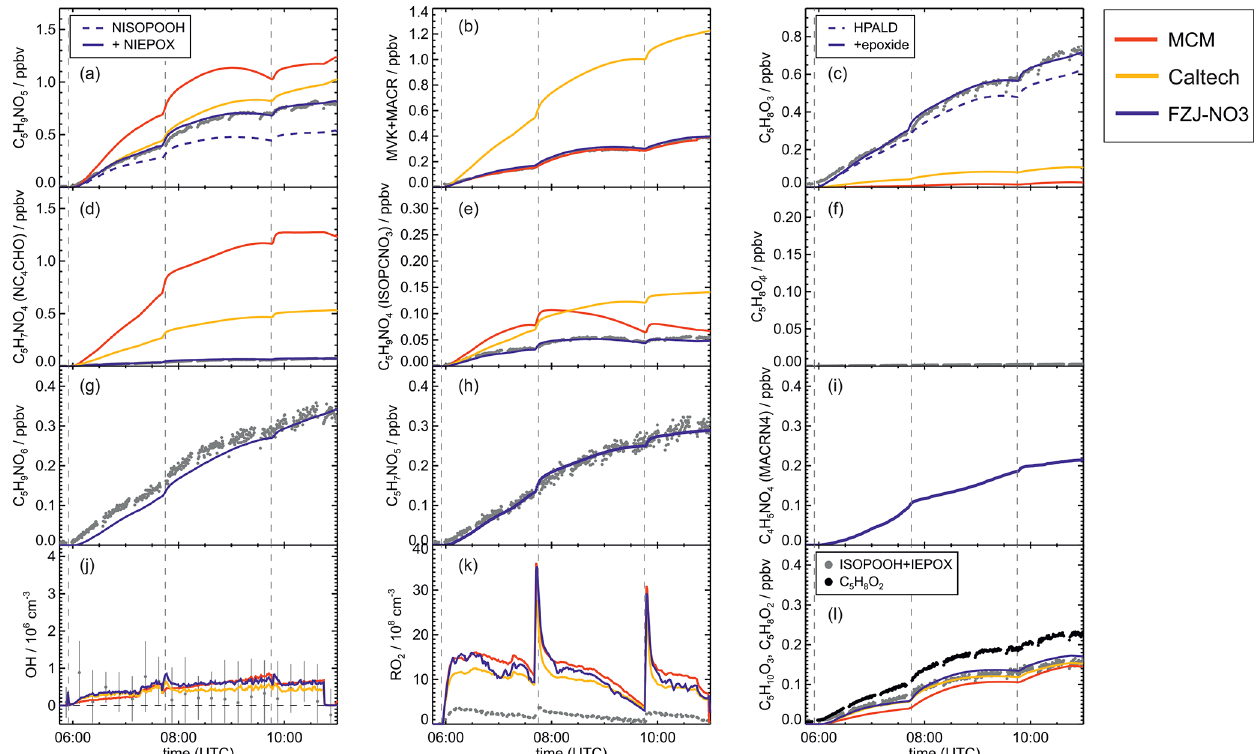
Figure A6. Comparison of results from model calculations applying the different isoprene NO 3 chemistry mechanisms for the experiment on 12 August 2018 (Experiment 3). MVK, MACR, NISOPOOH, ISOPCNO 3 and NC 4 CHO are produced from all mechanisms, whereas the other compounds are only produced from either 1,6-H-shift reactions or ring-closure reactions of nitrate alkoxy radicals, which are only implemented in the FZJ-NO3 mechanism. Grey and black dots are measured values. Measured organic peroxy radical concentrations only include part of the total RO 2 because the LIF instrument cannot detect a fraction of nitrate RO 2 (Vereecken et al., 2021). Organic products were detected by the Vocus PTR-MS instrument, which was only calibrated for MVK and MACR. All other traces are scaled to match best the results from the FZJ-NO3 mechanism.